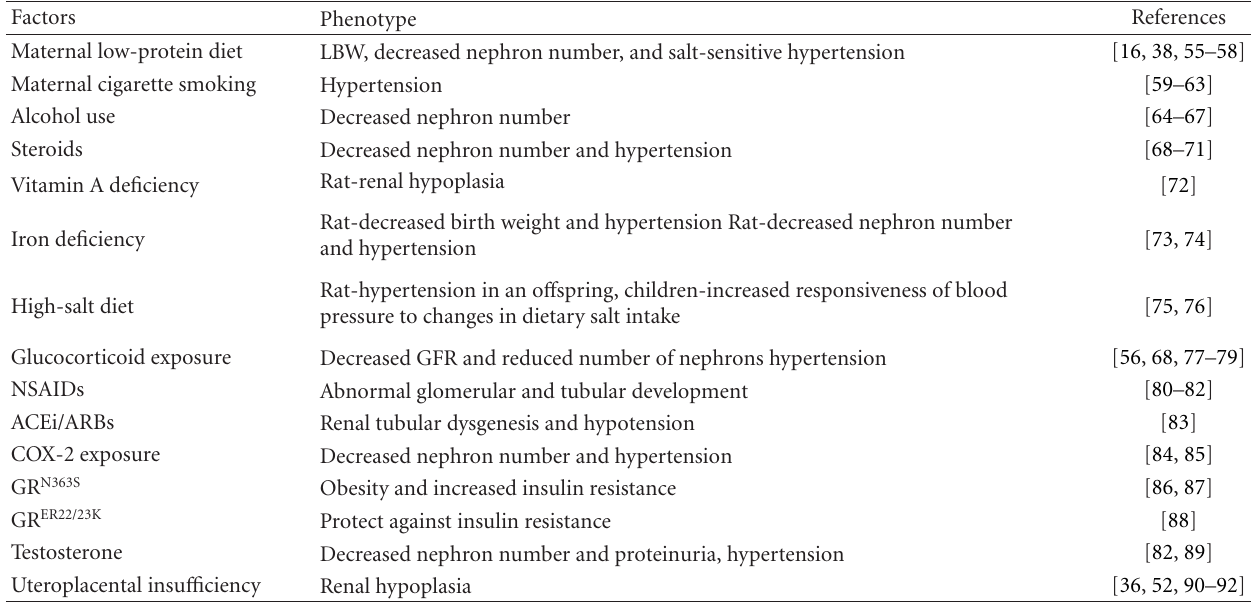
Table 2: E ff ect of environmental factors on kidney development and programming of renal dysfunction and blood